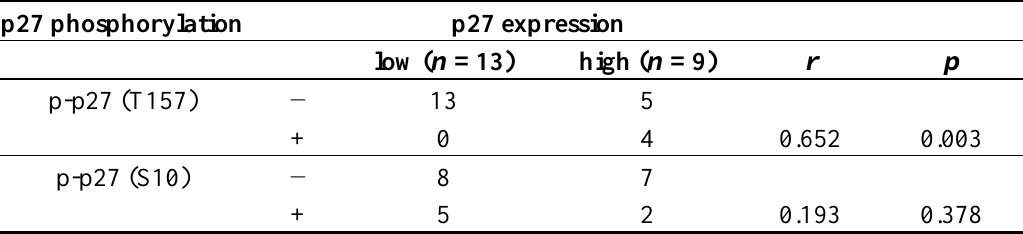
Table 2. Correlation of p27 and phosphorylated p27 expression in NASH-related HCC.